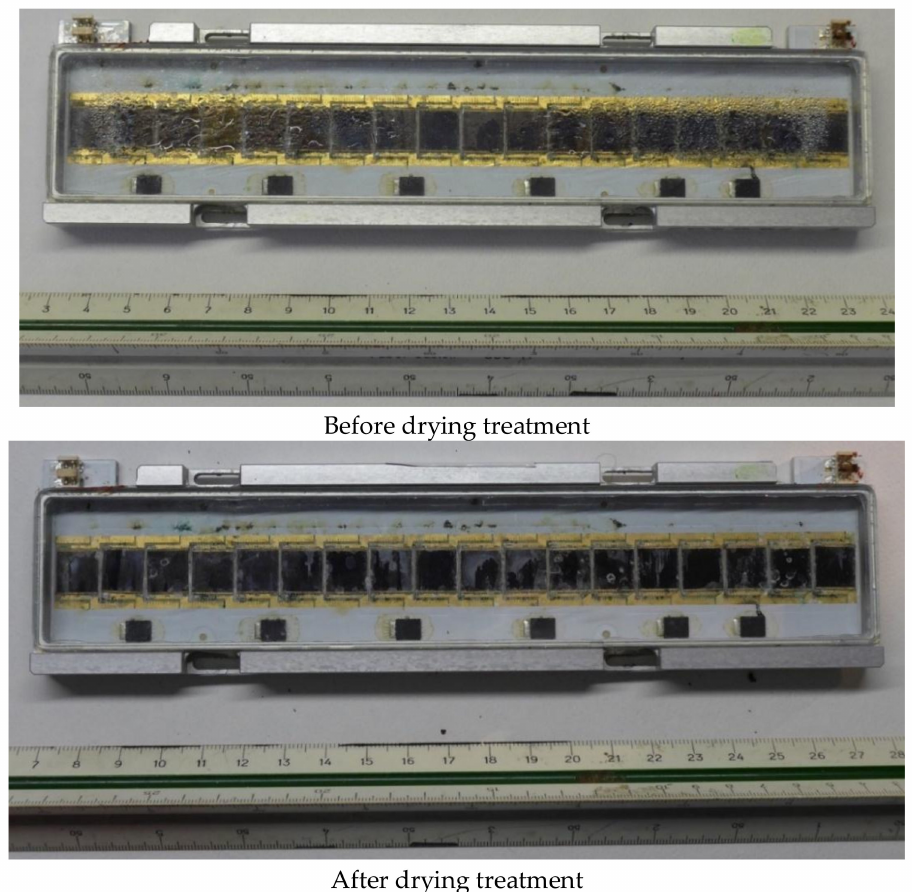
Figure 9. Module 202mg51-1 before and after the dehumidification treatment.